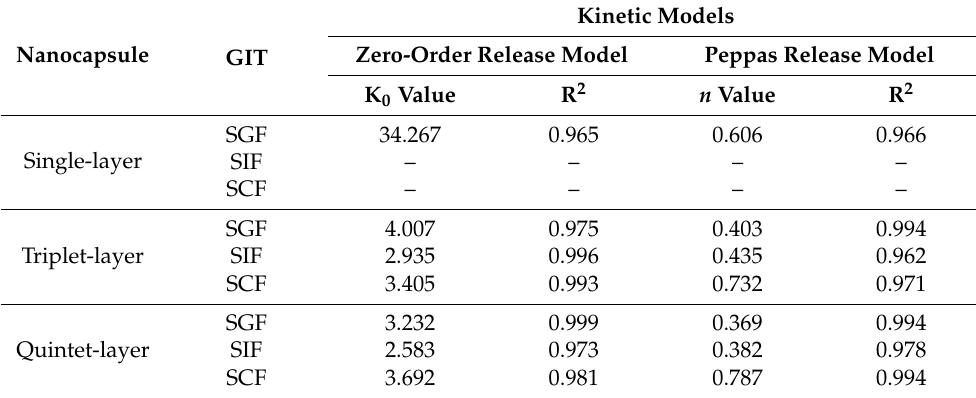
Table 1. Regression equation of drug-release kinetics of protein in the GIT.